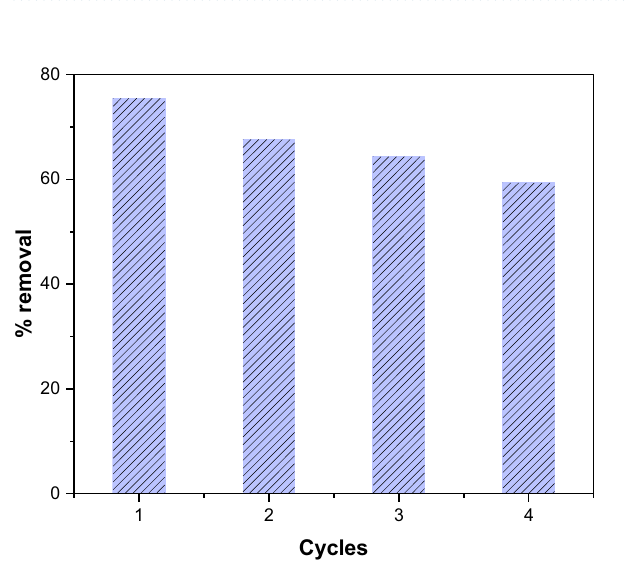
Table 4. Thermodynamic parameters of CR adsorption onto GSC WCO .